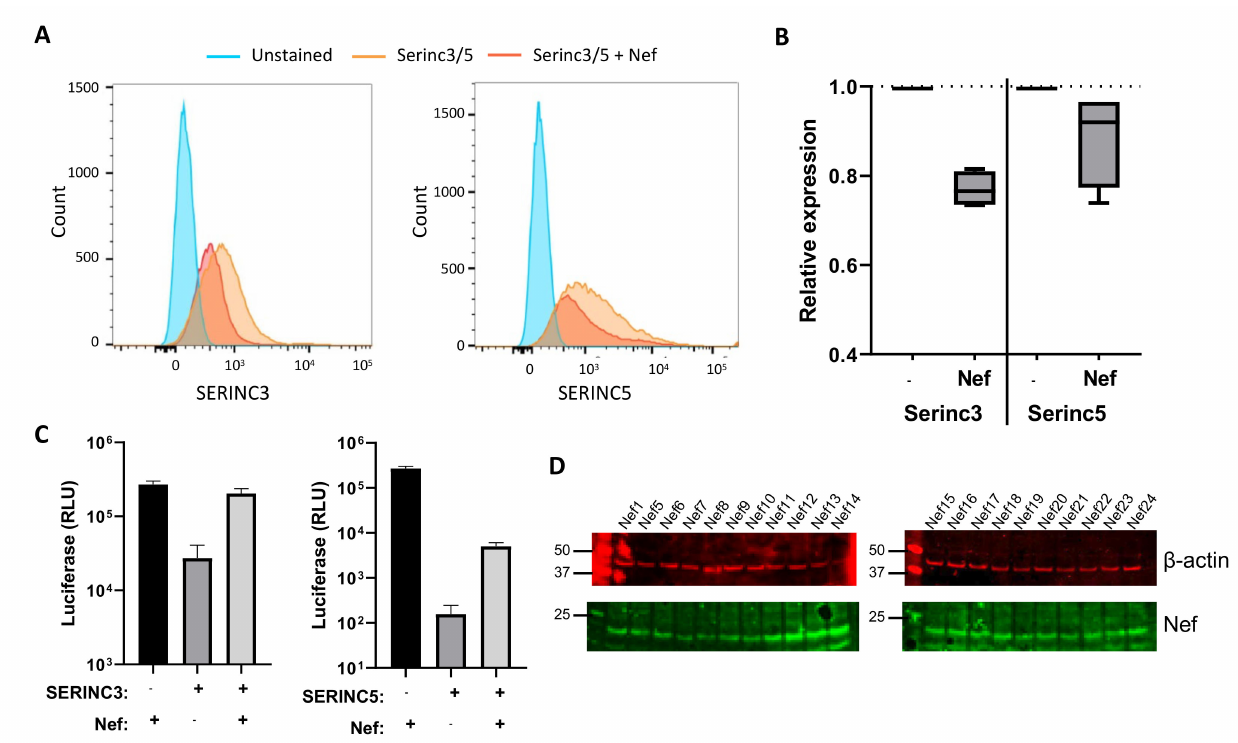
Figure 2. ( A ) Downregulation of serine incorporator 3 (SERINC3) and SERINC5 membrane expression by HIV-1 Nef. HEK293T cells were co-transfected with plasmids expressing Nef and SERINC3 or SERINC5 or in combination with a relevant empty vector. The surface expression of SERINC3 and SERINC5 (orange) or in combination with HIV-1 Nef (red) was determined by flow cytometry as the geometric mean of fluorescent intensity. Background fluorescent (blue) control was included. ( B ) Downregulation of SERINC3 and SERINC5 by Nef as shown as relative expression as compared to the control of four independent experiments ( p < 0.05). ( C ) The effect of SERINC3 (left panel) and SERINC5 (right panel) on HIV-1 infectivity: Infectivity of Bal26-pseudotyped HIV-1 produced in 293T cells overexpressing Nef (black bar), SERINC3 or SERINC5 (dark gray bar) and SERINC3 or SERINC5 in combination with Nef (light gray bar) in U87 CD4+CCR5+. Infectivity was determined by luciferase activity in relative light units (RLU). Mean ± SD are shown. ( D ) Expression of Nef from pcDNA3.1 encoding primary Nef proteins and β -actin levels were determined by Western